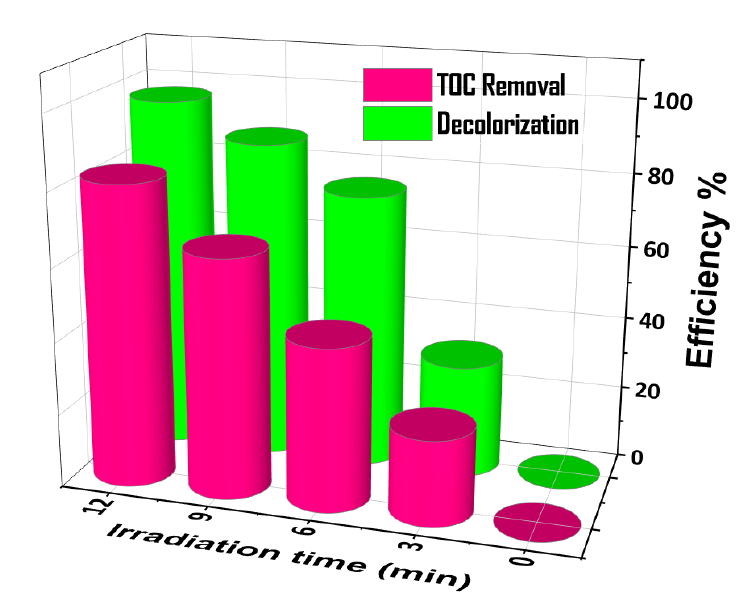
Figure 6. TOC removal vs. discoloration of Rhodamine B over as BiP-500 photocatalyst.